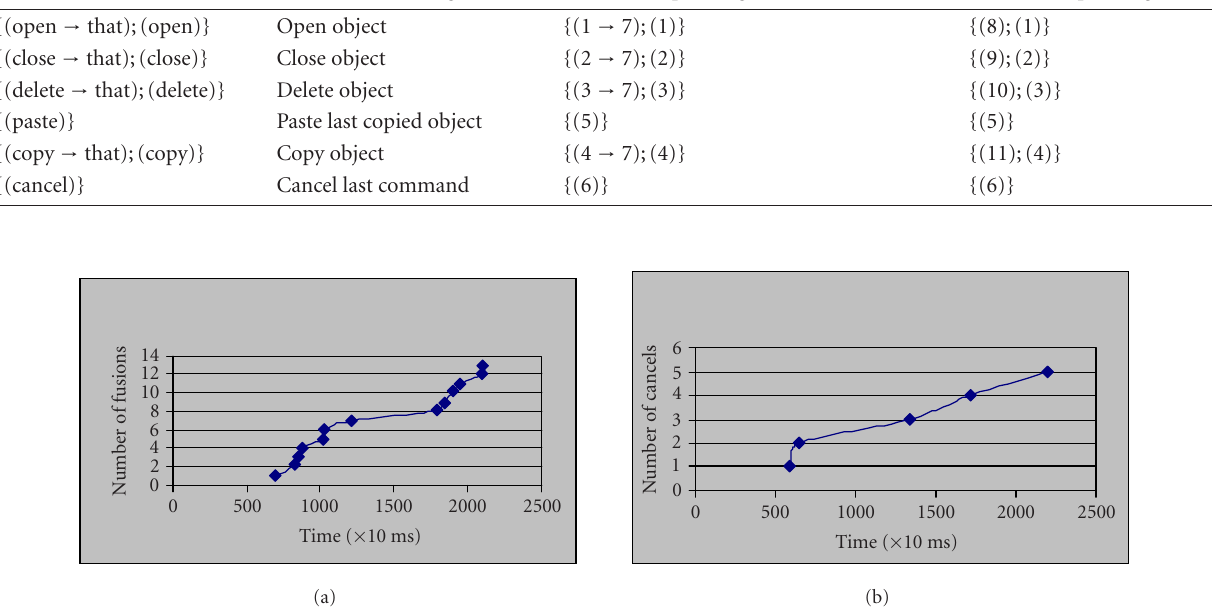
Table 3: Grammar of authorized sentences (the last two columns are codes used in the CPN). Set of sentences Set of corresponding semantic codes